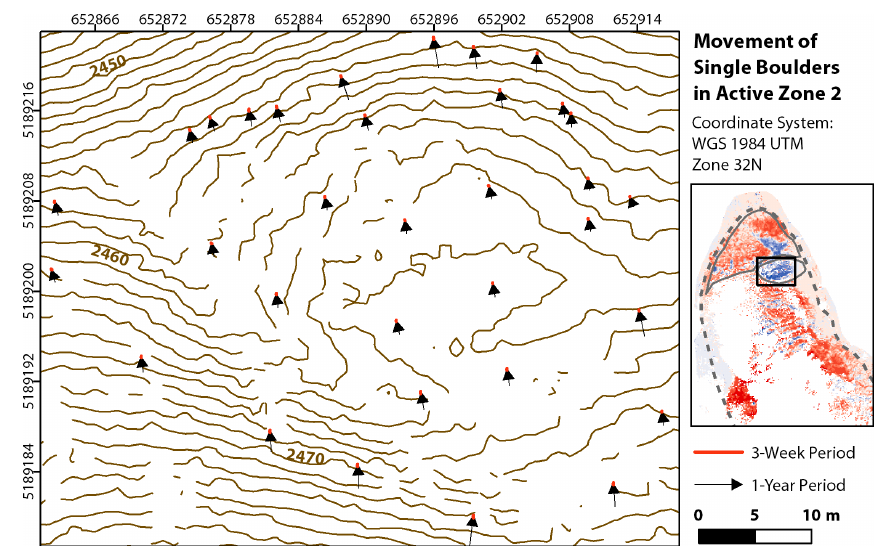
Figure 6. Movement of 33 single boulders in active zone 2 during the 3-week period (red) and the 1-year period (black). The boulder movements in this active zone are induced by creep, making them more homogeneous regarding distance and direction than the boulder movements in active zone 1. Because of their short distances, the boulder movements during the 3-week period are only visible as points.